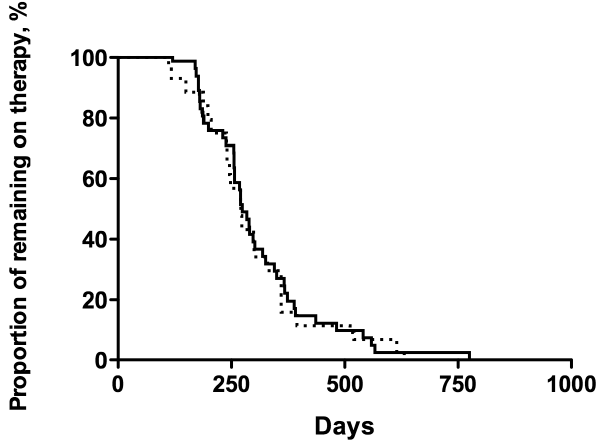
Figure 1. Kaplan-Meier analysis for patients with isoniazid (INH)-resistant tuberculosis (TB) remaining on treatment. Patients with low-concentration INH-monoresistant TB (dashed line) and high-concentration INH-monoresistant TB (solid line) received a similar duration of anti-TB therapy (p=0.761 by the log-rank test, hazard ratio=1.06, 95% confidence interval, 0.73–1.55).